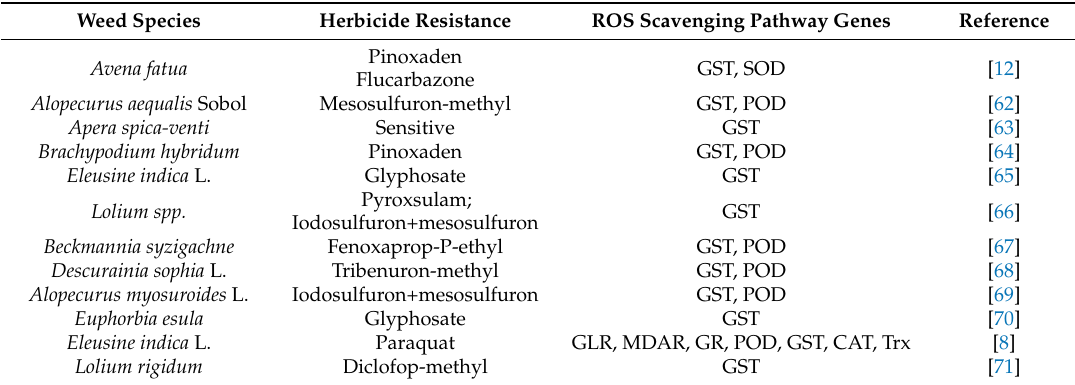
Table 3. Antioxidant-related genes differentially expressed identified from RNA-Seq studies performed for weed herbicide resistance investigation after herbicide